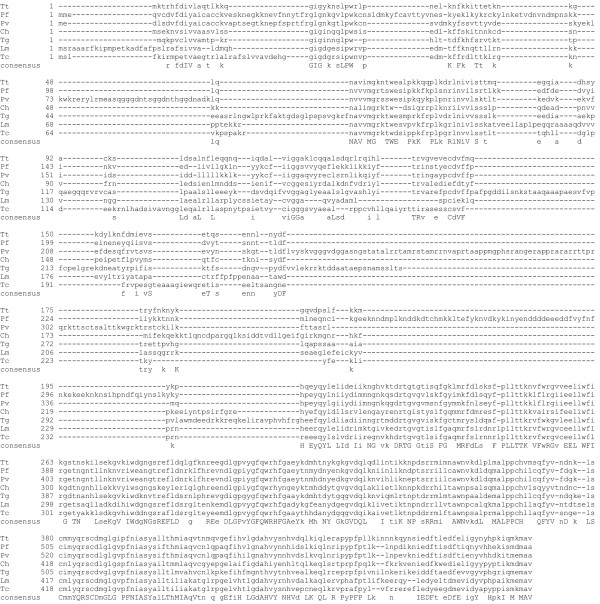
Comparison of the T. thermophila DHFR-TS bifunctional enzyme to other protozoa. Amino acid sequence comparison of Tetrahymena thermophila (Tt), Plasmodium falciparum (Pf), Plasmodium vivax (Pv), Cryptosporidium hominis (Ch), Toxoplasma gondii (Tg), Leishmania major (Lm) and Trypanosoma cruzi (Tc) DHFR-TS bifunctional enzyme.